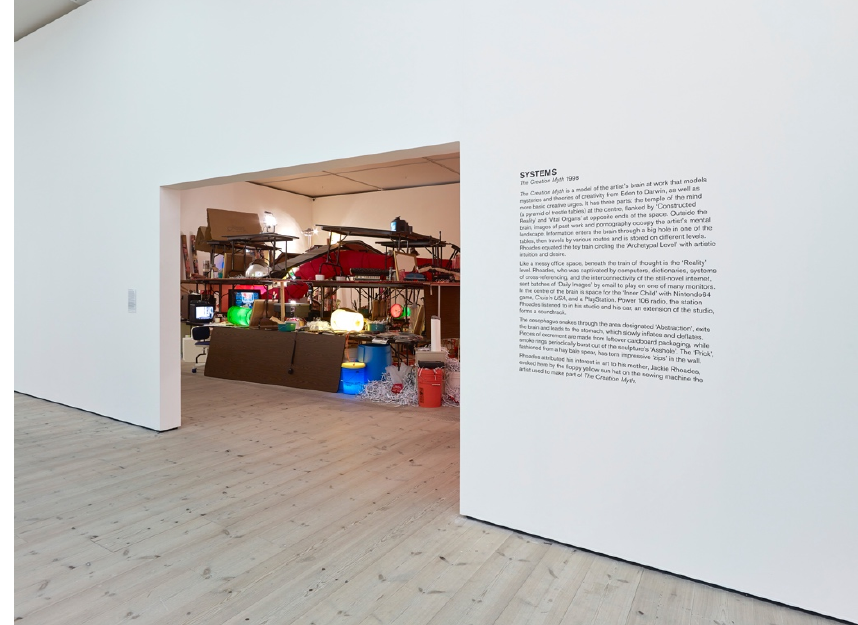
Figure 1. Jason Rhoades, The Creation Myth 1998/2015. Installation view. BALTIC Centre for Contemporary Art, Gateshead, United Kingdom. Friedrich Christian Flick Collection, Berlin. Photo: John McKenzie © 2022 BALTIC Centre for Contemporary Art.